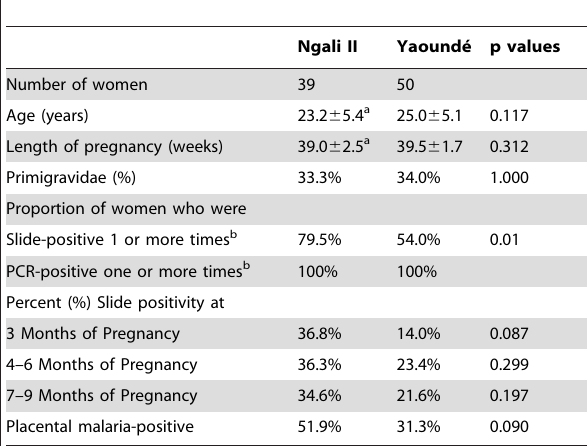
Table 1. Characteristics of women followed